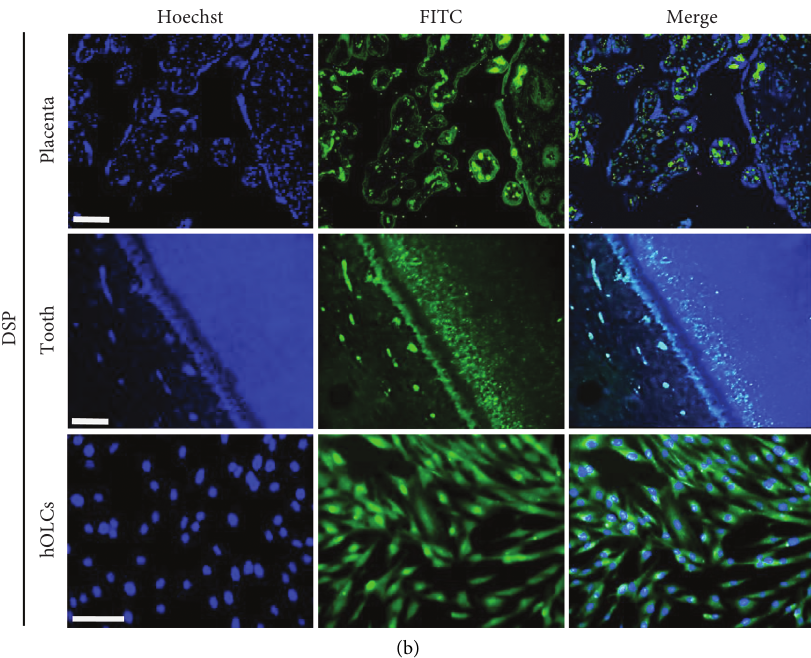
Figure 2: Immunocytochemical detection of odontogenic markers DMP-1 and DSP in hOLCs. Positive immunostaining (green) of tissue control (a) mammary gland for DMP-1 and (b) placenta for DSP. Positive staining of dental tissue in the odontoblast layer and min- eralization in front of the dentin. To determine the presence and location of the odontogenic markers in the differentiated cells, an anti- DMP-1 (a) or anti-DSP (b) antibody conjugated with FITC (green) was used, and the nuclei were counterstained with Hoechst stain (blue). Note the positivity of these markers in hOLCs, with both a nuclear and cytoplasmic distribution. A Zeiss Axio Imager A2 microscope was used to obtain the images. Scale bar: 50 µ m.